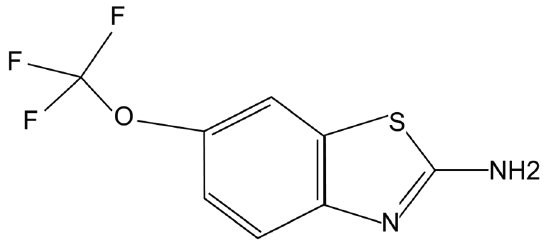
Figure 1. Chemical structure of riluzole.